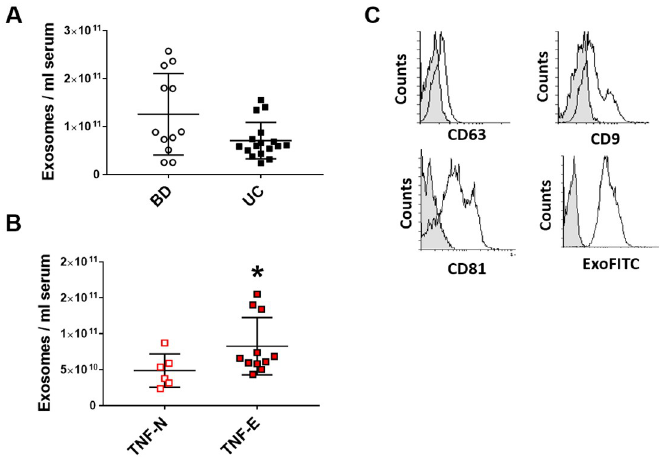
Fig 1. Circulating exosomes isolation and characterization. Exosomes were isolated from serum by Exoquick and quantified by Exocet. Panel A and B illustrate the mean concentration of exosomes in 12 blood donor (CTRL) and 17 UC patients, subdivided in anti- TNF α na ï ve (TNF-N) and anti-TNF α antagonist exposed (TNF-E). � p < 0.05 compared to anti- TNF α na ï ve patients C) Exosomes were validated for the expression of exosomal markers by flow cytometry. Exosome-bound beads (white peak) were compared with beads alone (grey peak).